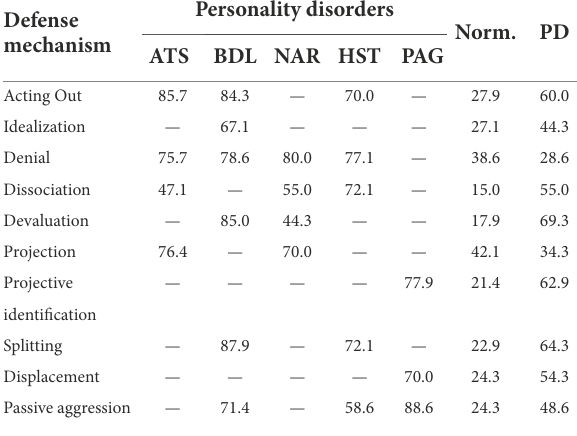
TABLE 2 Probabilities (%) of defense mechanisms for cluster-B personality disorders.